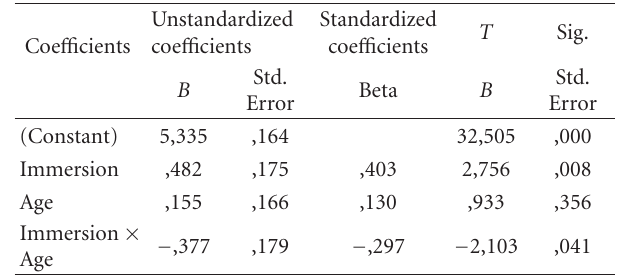
Table 4: Regression results.